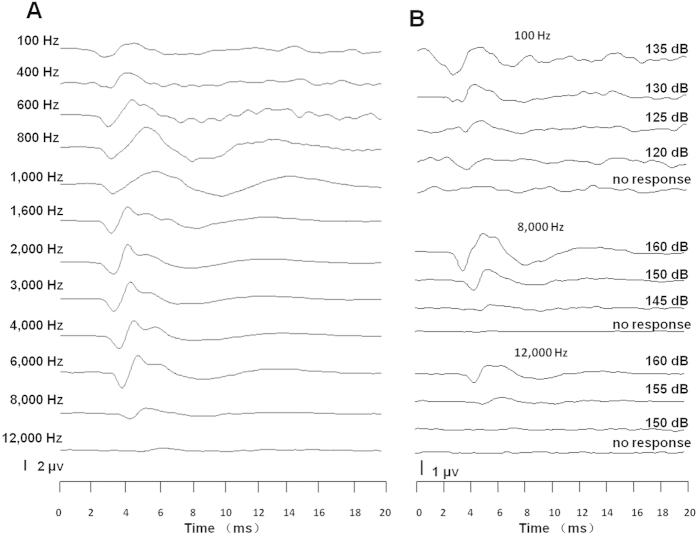
Typical AEP waveforms from a 35 mm zebrafish.(A) AEPs evoked by tone bursts of different frequencies. The sound intensities were 140 dBw for tone bursts from 100 Hz to 6 kHz, 150 dBw for 8 kHz and 155 dBw for 12 kHz. (B) AEP threshold tracking at 100 Hz (upper panel), 8 kHz (middle panel) and 12 kHz (lower panel).